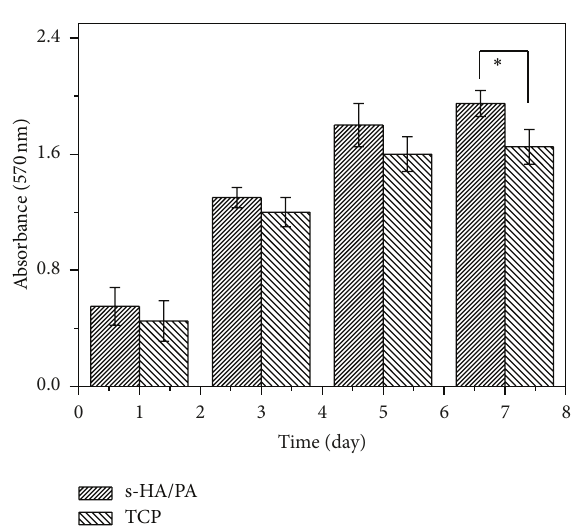
Figure 5: ALP activity of MG63 cells cultured on s-HA/PA compos- ite, TCP as controls, ∗ 𝑃 < 0.05